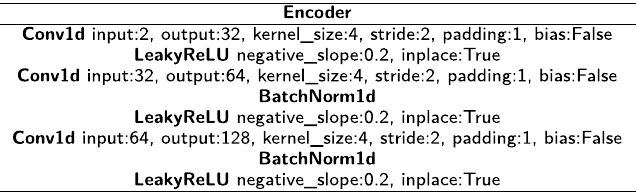
Table 1 Parameters and modules of the encoder